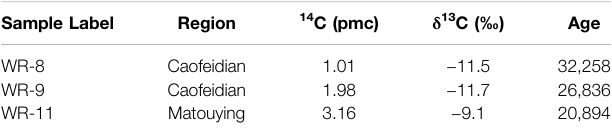
TABLE 2 | Groundwater age of geothermal water at the Caofeidian and the Matouying. Sample